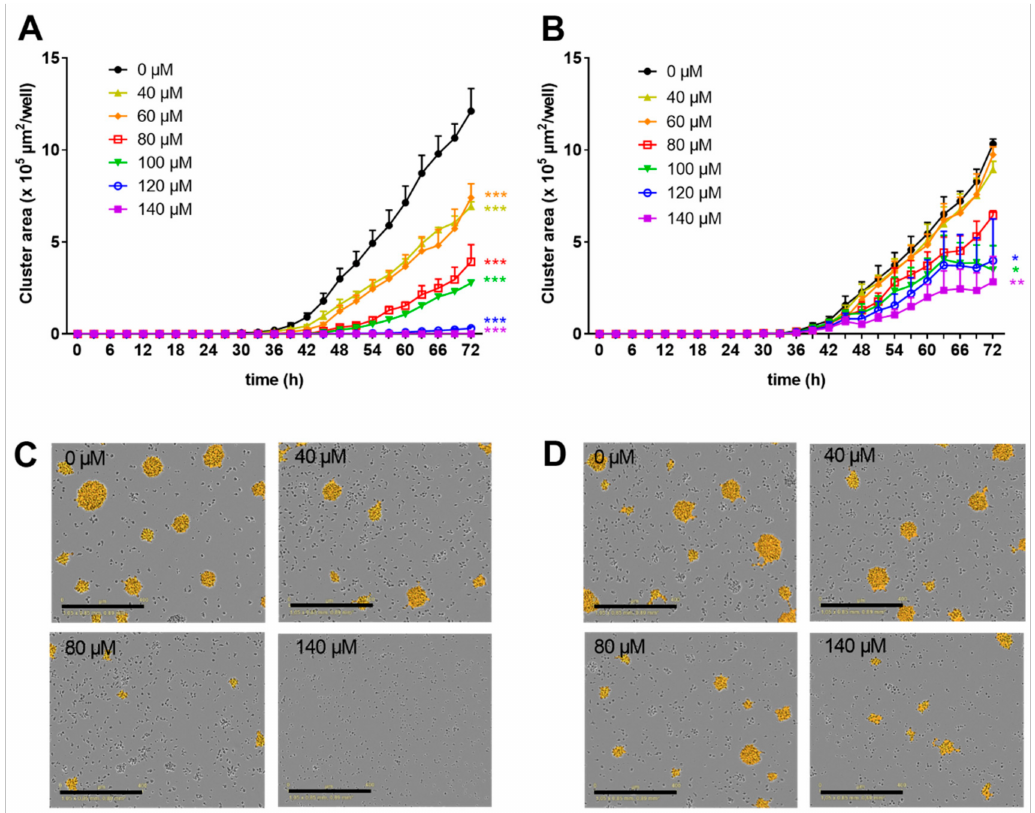
Figure 1. Zinc aspartate suppressed proliferation in freshly stimulated and pre-activated T cells. Human resting T cells were freshly stimulated ( A ) or pre-activated for 48 h ( B ) with anti-CD3/CD28 antibodies and cultured with increasing concentrations of zinc aspartate. Kinetic measures of the cluster area per well were recorded by the IncuCyte S3 imaging system at 3 h intervals for 72 h. Data are presented as the mean + standard error of the mean (SEM) from three independent experiments. (* p < 0.05, ** p < 0.01, *** p < 0.001). Representative images of proliferating cell clusters from freshly stimulated ( C ) or pre-activated ( D ) T cells treated with the indicated concentration of zinc aspartate are shown. Scale bar, 400 µ